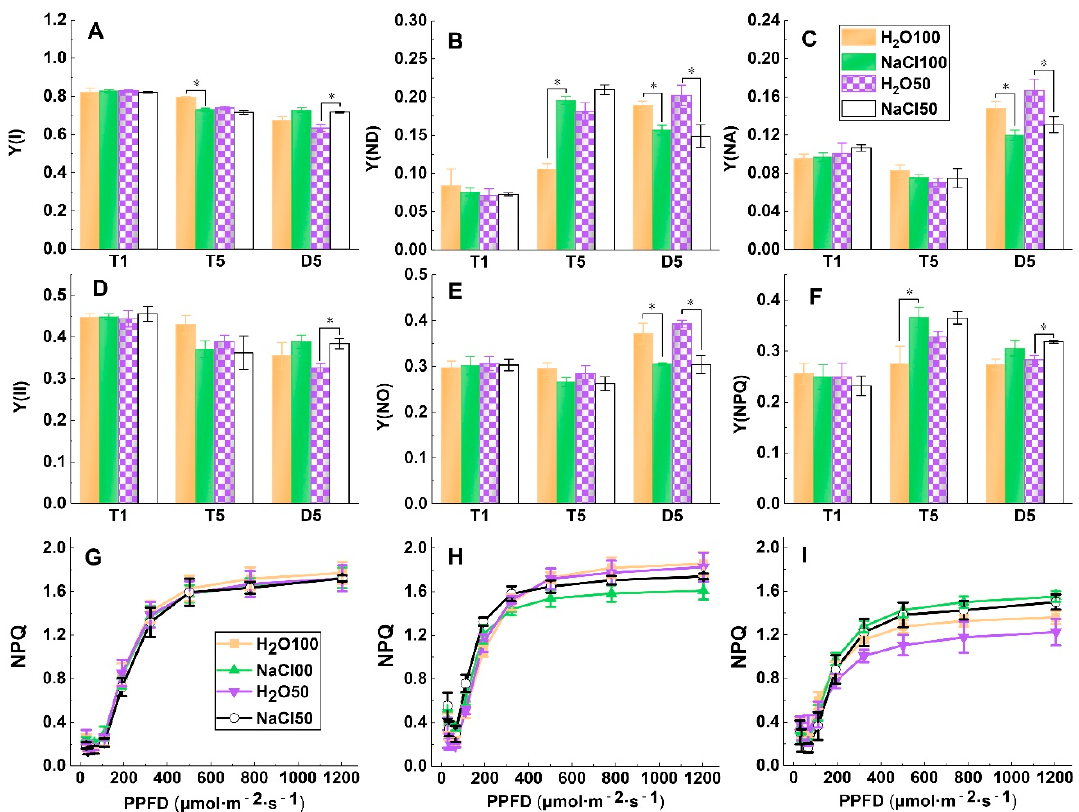
Figure 3. The effect of soil salinity on energy conversion in PSI and PSII of tomato leaves under subsequent drought stress. Y(I) ( A ); Y(ND) ( B ); Y(NA) ( C ); Y(II) ( D ); Y(NO) ( E ); Y(NPQ) ( F ); and the rapid light response curves of NPQ of tomato plants at T1 ( G ); T5 ( H ); and D5 ( I ). T1, the first day following soil salt pre-treatment; T5, the fifth day following soil salt pre-treatment; D5, the fifth day after the subsequent drought treatment. The results are displayed as mean values of three independent biological replicates, means ± SD, * P < 0.05, student’s t-test.